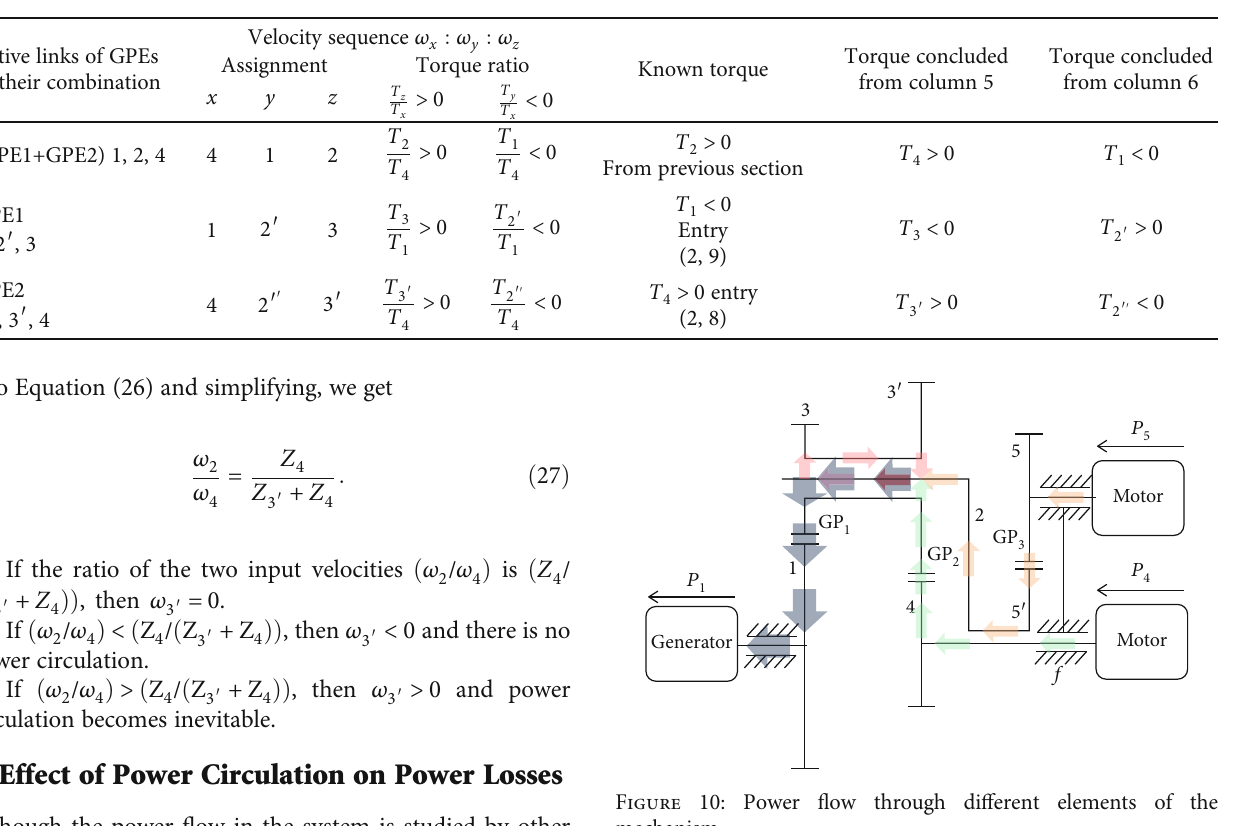
Table 1: Gear pair entity, gear train entity (GTE), and torque for the mechanism shown in Figure 1 which has a velocity sequence of ω : ω : ω : ω 1 2 3 :